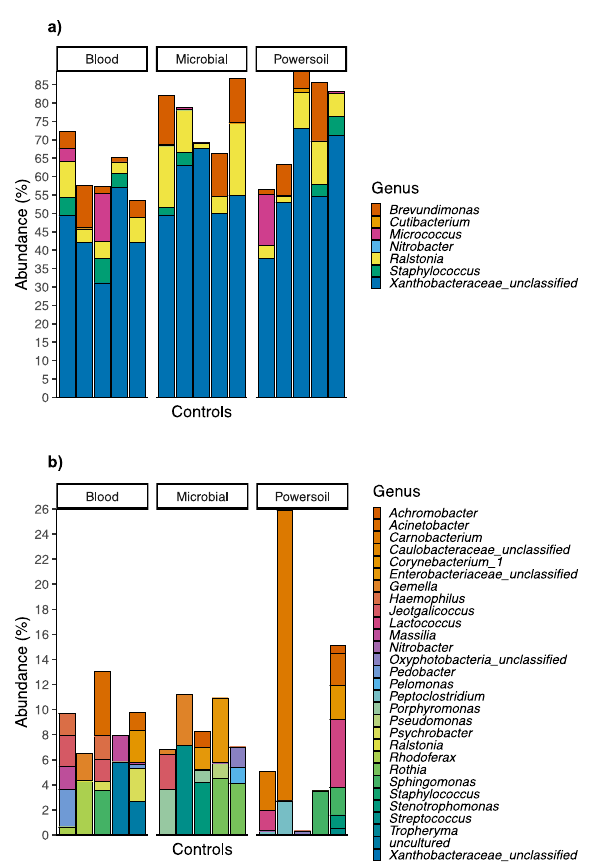
Fig. 5 Distribution of the relative abundance and taxonomic identi fi cation of OTUs found in the controls for each version of the pipeline. a Core microbiota of the methodological controls. Average abundances of OTUs present in at least 40% of controls for every version of the pipeline. b OTUs found only in the controls extracted with one or the other extraction kit. Average abundance of OTUs present in at least 40% of the controls from one of the versions of the pipeline, but not the others (different DNA extraction